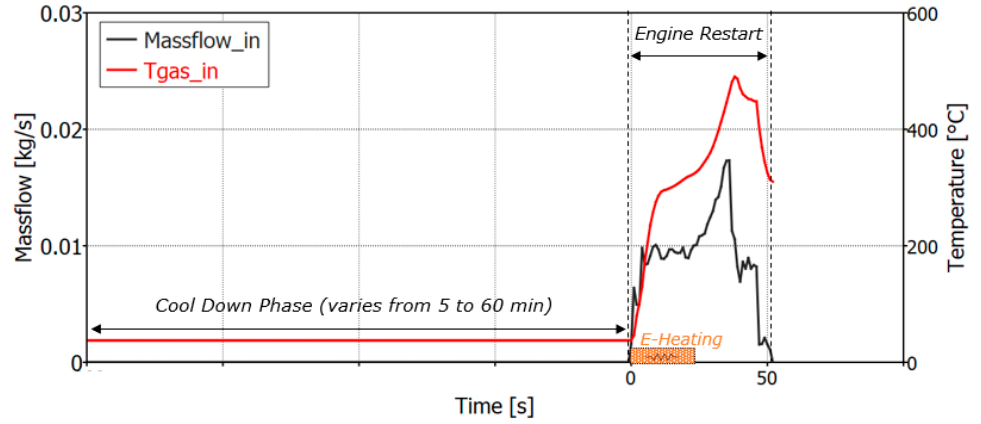
Figure 20. Test scenario for the virtual architecture benchmark.